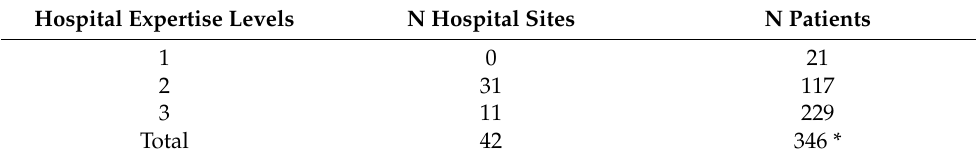
Table 3. Distribution of operated patients according to the hospital expertise